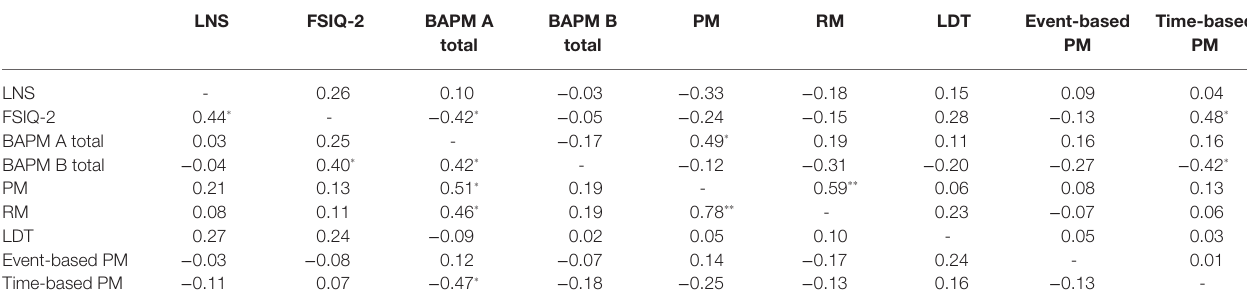
TABLE 3 | Correlations between PM predictors and PM